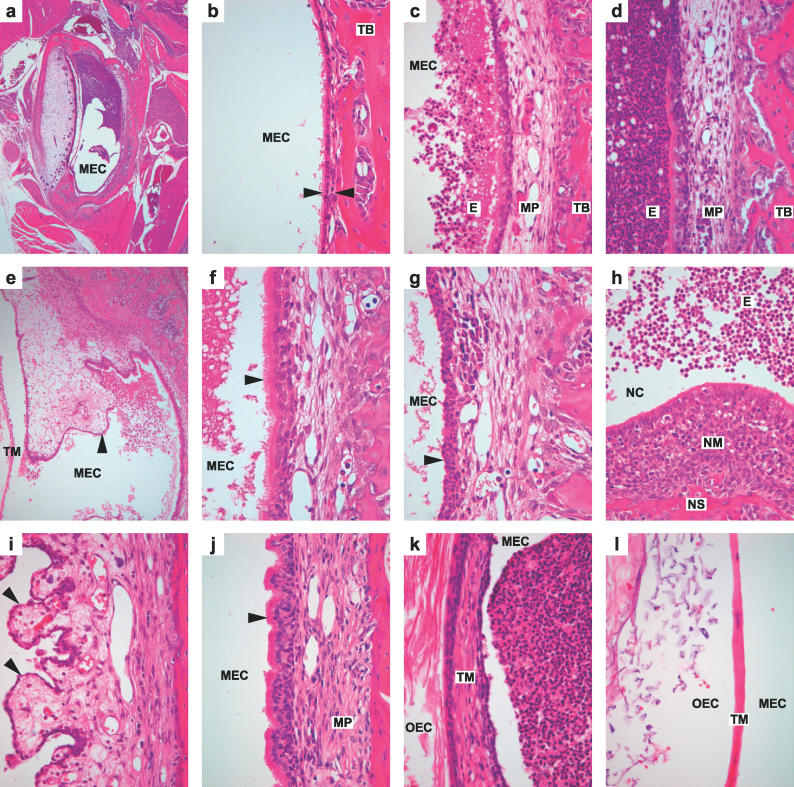
Histology of Middle Ear and Nose in Wild-Type and Junbo Mutant MiceImages (a–h) are from 13-d-old postnatal mice and are given with their original magnification (a) Jbo/+ dorsal section of MEC partly filled with exudate ×40, (b) +/+ normal middle ear temporal bone covered with thin mucoperiosteum (arrowheads) ×400, (c) +/+ inflamed middle ear with thickened mucoperiosteum with neutrophil leukocyte infiltrates and neutrophil-rich exudates in the MEC ×400, (d) Jbo/+ middle ear with more severe suppurative exudation into the MEC ×400, (e) Jbo/+ inflamed edematous polyp (arrowhead) of un-resorbed embryonic middle ear connective tissue, tympanic membrane ×100, (f) Jbo/+ MEC lined by ciliated columnar cells (arrowhead) ×600 (g) Jbo/+ MEC lined by basal cells (arrowhead) ×600, (h) Jbo/+ suppurative rhinitis: nasal cavity with suppurative exudate, nasal septum with inflamed nasal mucosa ×200.Images (i–l) are of adult (180-d) Jbo/+ middle ear with chronic suppurative OM; changes include (i) fibrous polyps (arrowheads) ×200, (j) hyperplasia of ciliated epithelial cells (arrowhead) and fibrosis of mucoperiosteum stroma ×400, and (k) fibrous thickening of the tympanic membrane, outer ear canal ×400 compared with (l) normal +/+ tympanic membrane, outer ear canal ×400. E, exudate; MP, mucoperiosteum; NC, nasal cavity; NM, nasal mucosa; NS, nasal septum; OEC, outer ear canal; TB, temporal bone; TM, tympanic membrane